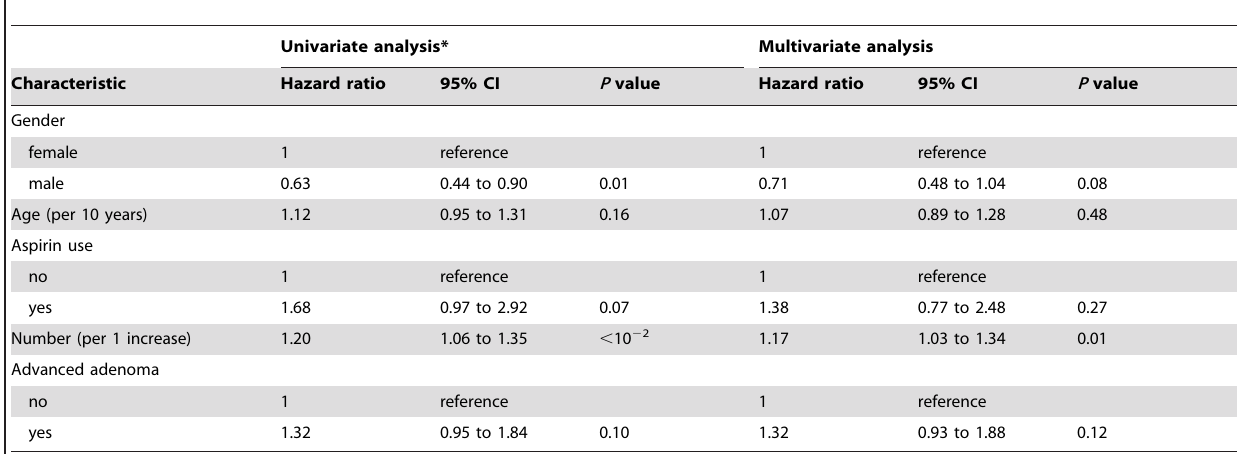
Table 5. Hazard ratios for adenoma recurrence, according to baseline patient and adenoma characteristics (447 followed up